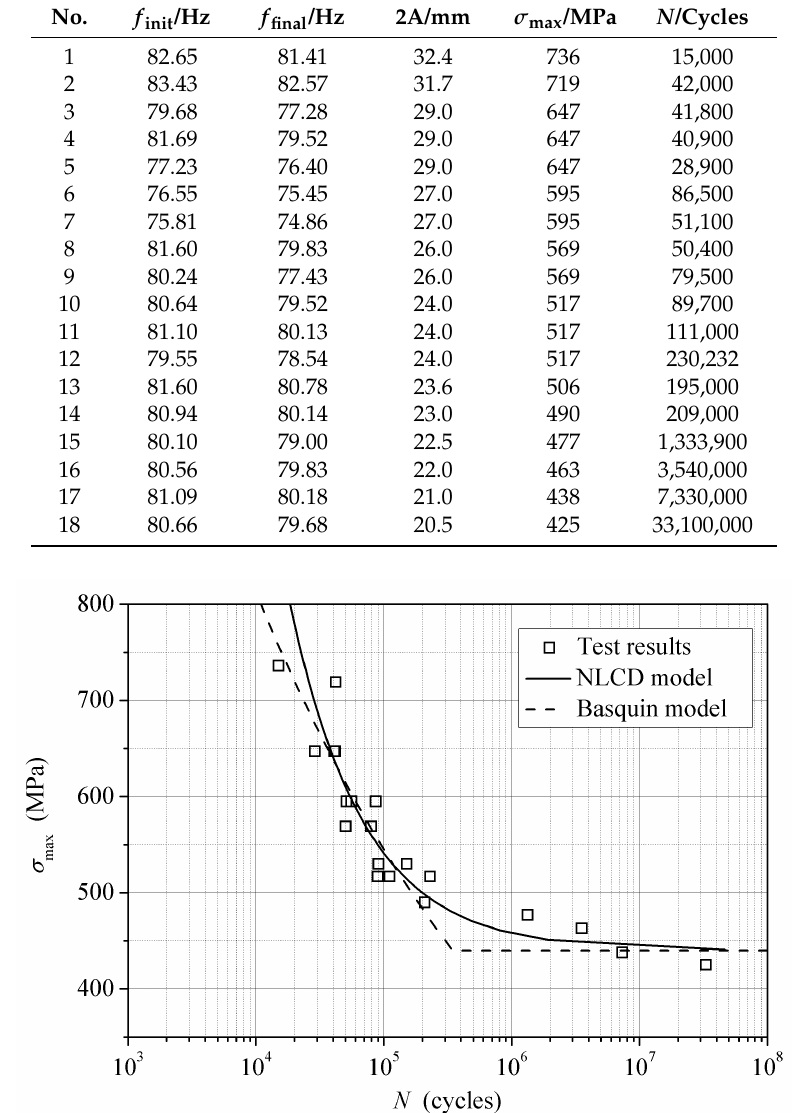
Figure 4. S-N curves of Ti–6Al–4V under stress ratio of −1.